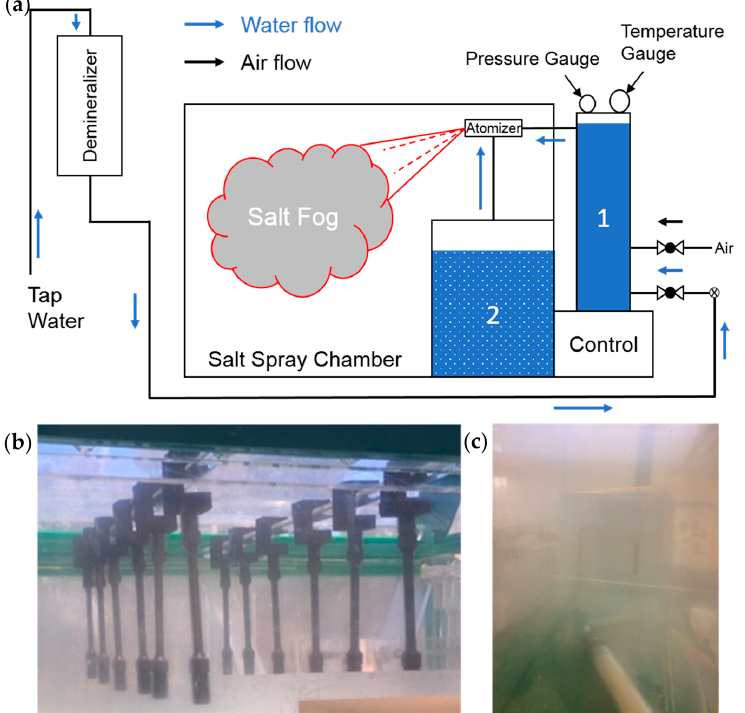
Figure 1. Schematic of the salt spray chamber (“salt fog”). In the sketch ( a ), the saturation tower and salt solution reservoir are labeled 1 and 2, respectively. The flow of air and water are indicated. Samples are seen hanging from 3D printed sample holders in ( b ). Visible “fog,” in ( c ), generated from the atomized salt solution located in the reservoir.